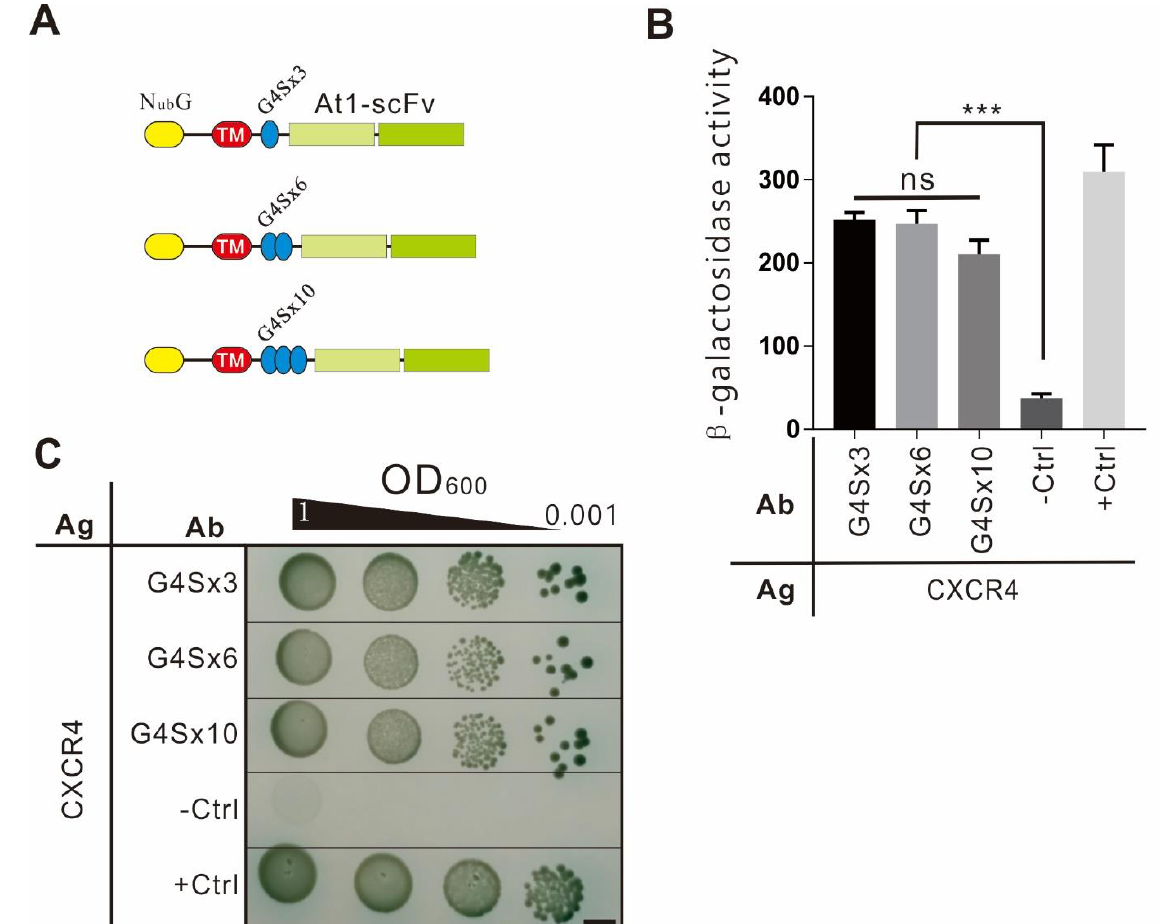
Figure 4. Optimization of flexible peptide length. ( A ) Diagram of scFv module with different lengths of flexible linkers. Flexible linkers composed of 3×GGGGS, 6×GGGGS, or 10×GGGGS were constructed into antibody modules, which were tested for their interaction strength with the antigen module using the following assays. ( B ) β -Gal assay. The interaction strength between CXCR4 and antibody modules containing variable lengths of the flexible linker was measured using the β -galactosidase assay. The positive and negative controls were the same as in Figure 2E. ( C ) Cell growth assay. The growth of hybrid cells harboring the antigen and antibody module as in ( B ) was evaluated by the selection medium. The bar indicates 5 mm.